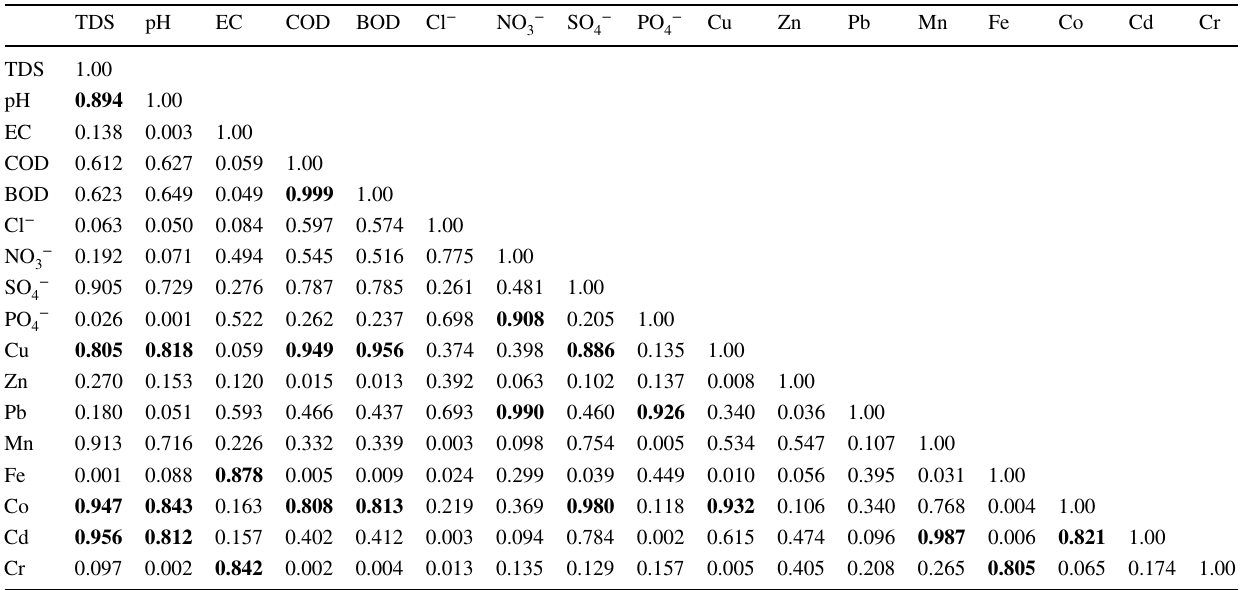
Significant correlation at 0.01 and 0.05 levels are